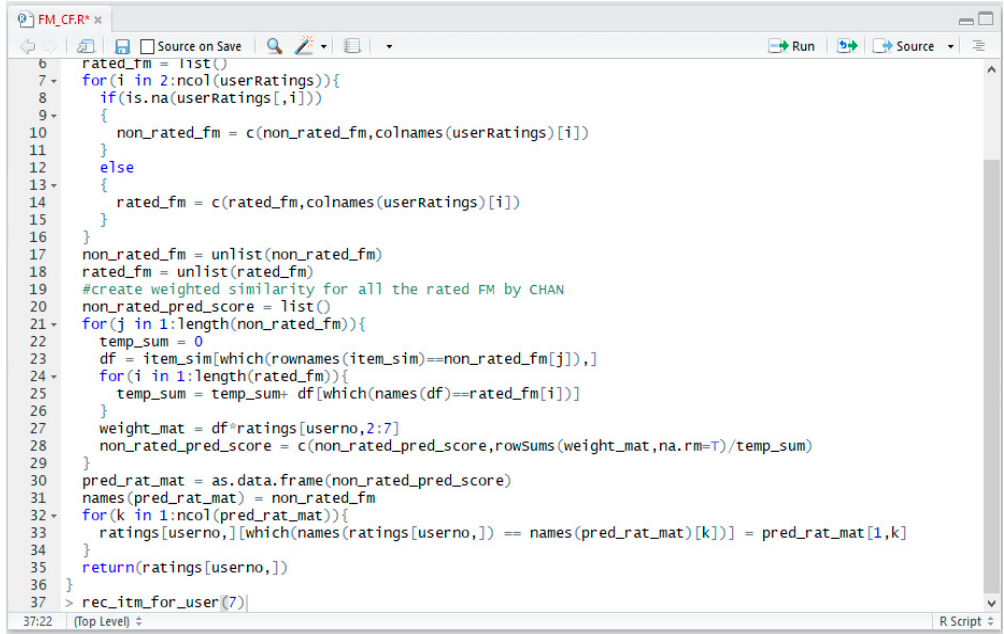
Figure 6. Screenshot of the operation code that is part of recommendation models using R. Sensors 2019 , 19 , x FOR PEER REVIEW